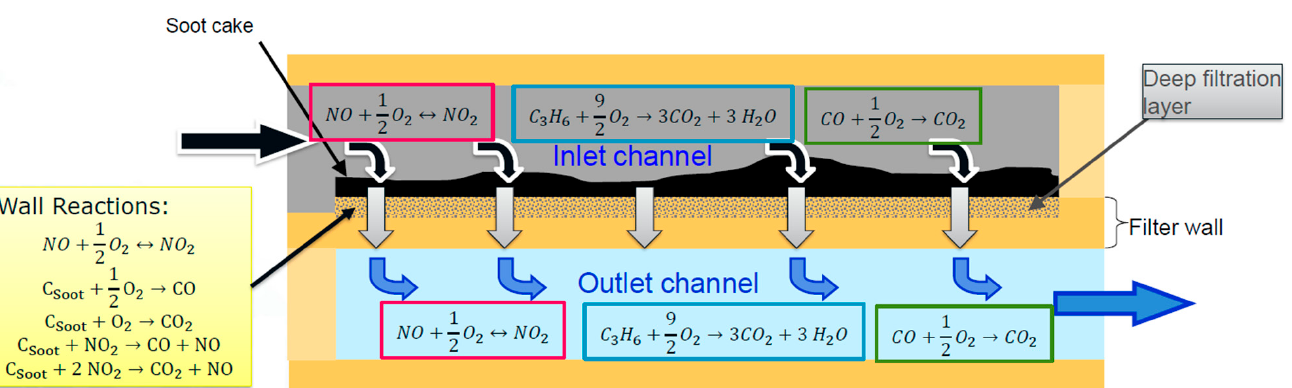
Figure 12. DPF model overview.